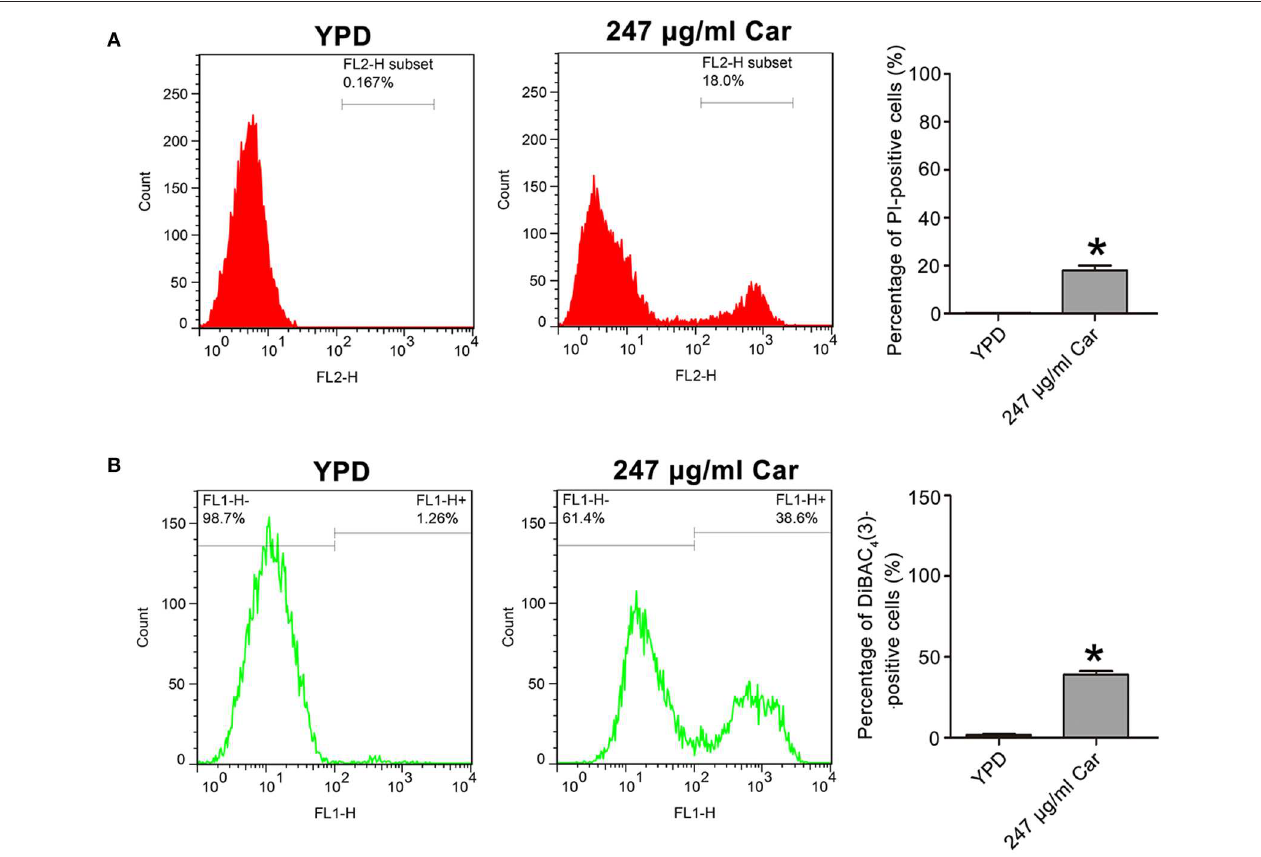
FIGURE 2 | Effects of carvacrol on cell membrane were examined in C. albicans . (A) Cell membrane integrity was analyzed using PI staining. The histogram showed the percentage of PI-positive cells, and data were expressed as mean ± SD ( n = 3). * P < 0.05. (B) Plasma membrane potential was determined using DiBAC 4 (3) staining. The percentage of DiBAC 4 (3)-positive cells was shown in the histogram, and data were exhibited as mean ± SD ( n = 3). * P <